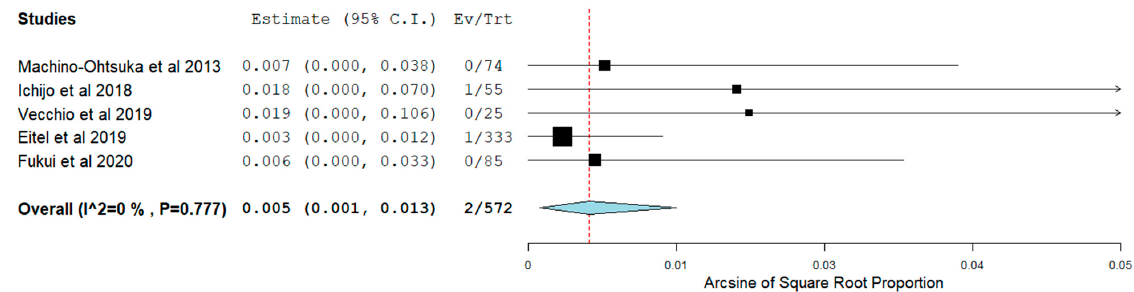
Figure 3. Major bleeding post-ablation in patients with HFpEF.